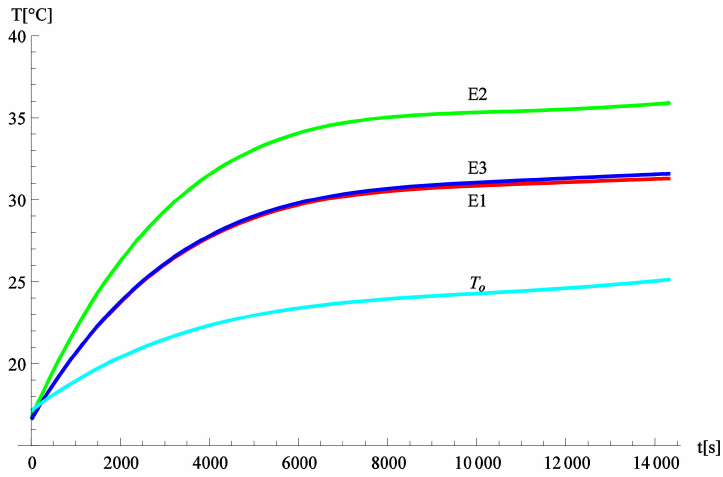
Figure 5. Time variation of the enclosure temperature – measurement (E1, E2, E3: enclosure temperatures; T o : ambient temperature).